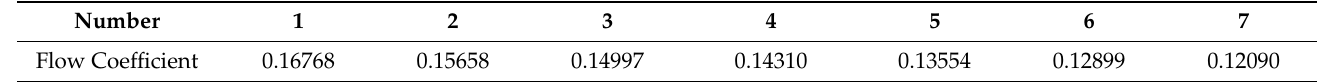
Table 1. Flow coefficient for the calculation of the performance of the